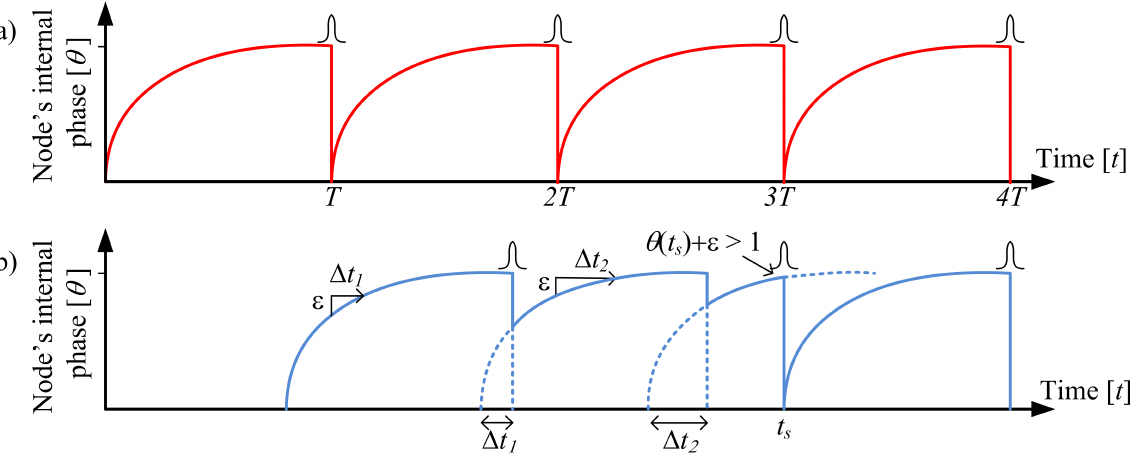
Figure 1. The firefly inspired time synchronization mechanism. (a) A node fires a pulse when its internal time t equals a multiple n of the oscillation period T . (b) An adjacent node responds to a neighbor’s pulse by incrementing its internal phase such that θ ( nT + ∆ t ) = θ ( nT ) + (cid:15) n